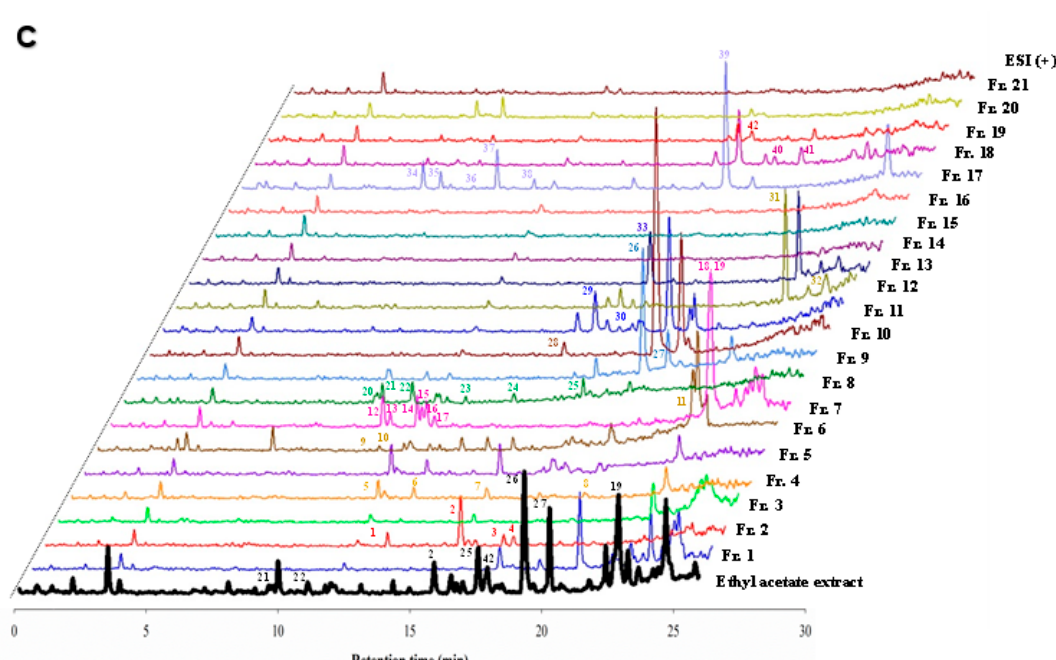
Figure 1. ( A ) Anti-inflammatory activities of 21 column fractions derived from K. flaccidum var. zivo against iNOS, in comparison with the parent ethyl acetate extract and the positive control parthenolide; ( B ) Orthogonal partial least squares discriminant analysis (OPLS-DA) discriminating active and inactive fractions; and ( C ) UHPLC-qMS profiling of the ethyl acetate extract and its 21 column fractions with compound numbers labeled beside respective peaks.